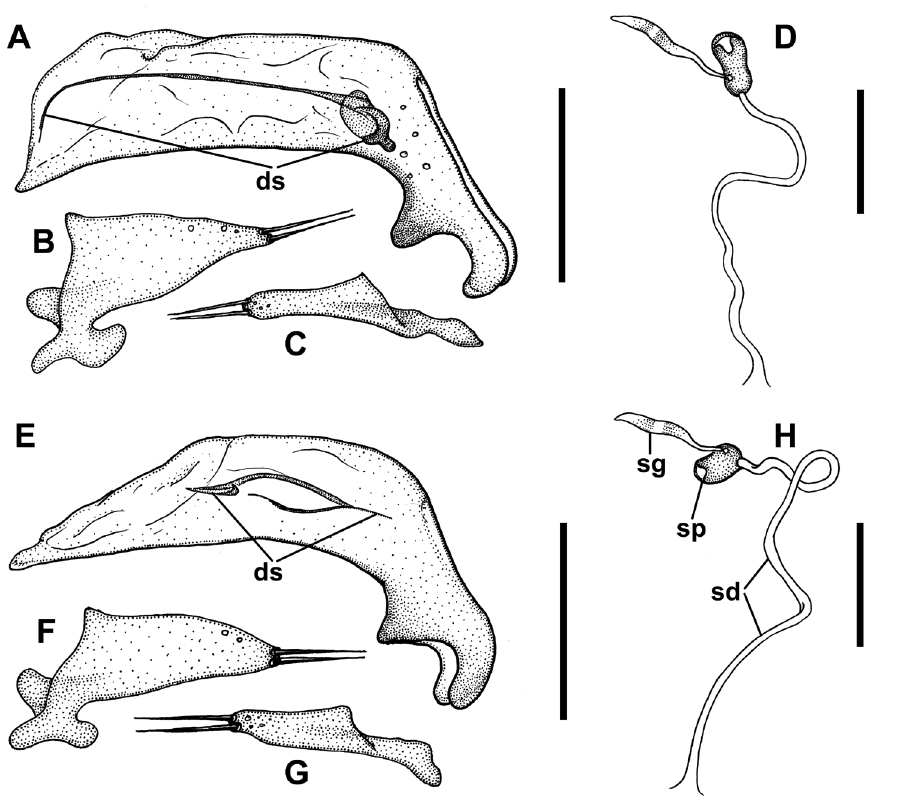
Figure 7. Line drawings of male genitalia and female spermathecae of Pelodiaetus species. P. nunni (NZ, Canterbury, Ahuriri Scenic Preserve): A median lobe, right lateral aspect B left paramere, left lateral aspect C right paramere, right lateral aspect D spermatheca. P. sulcatipennis (NZ, Otago, Outram): E me- dian lobe, right lateral aspect F left paramere, left lateral aspect G right paramere, right lateral aspect H spermatheca. Abbreviations: ds – dorsal sclerites; sd – spermathecal duct; sg – spermathecal gland; sp – spermatheca. Scale bars: 0.1 mm ( A, B, C, E, F, G ); 0.05 mm ( D, H Pelodiaetus sulcatipennis Jeannel Figs. 1AC, 2AC, 3, 4A, 5, 6A, 7E-H, 8, 9B-C Pelodiaetus sulcatipennis Jeannel, 1937: 277 (original description); Jeannel 1963 (fig- ures, key, distribution); Moore 1980 (key, distribution).